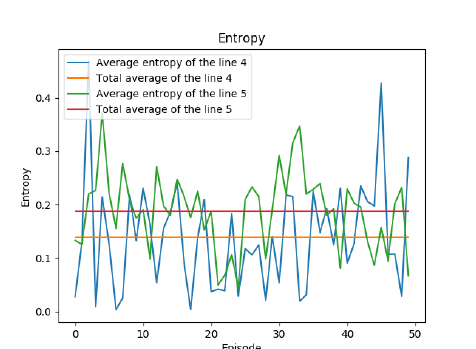
Figure20. Comparisonof the averageagent entropy with theconfigurations shown in lines 4 and 5 of Table